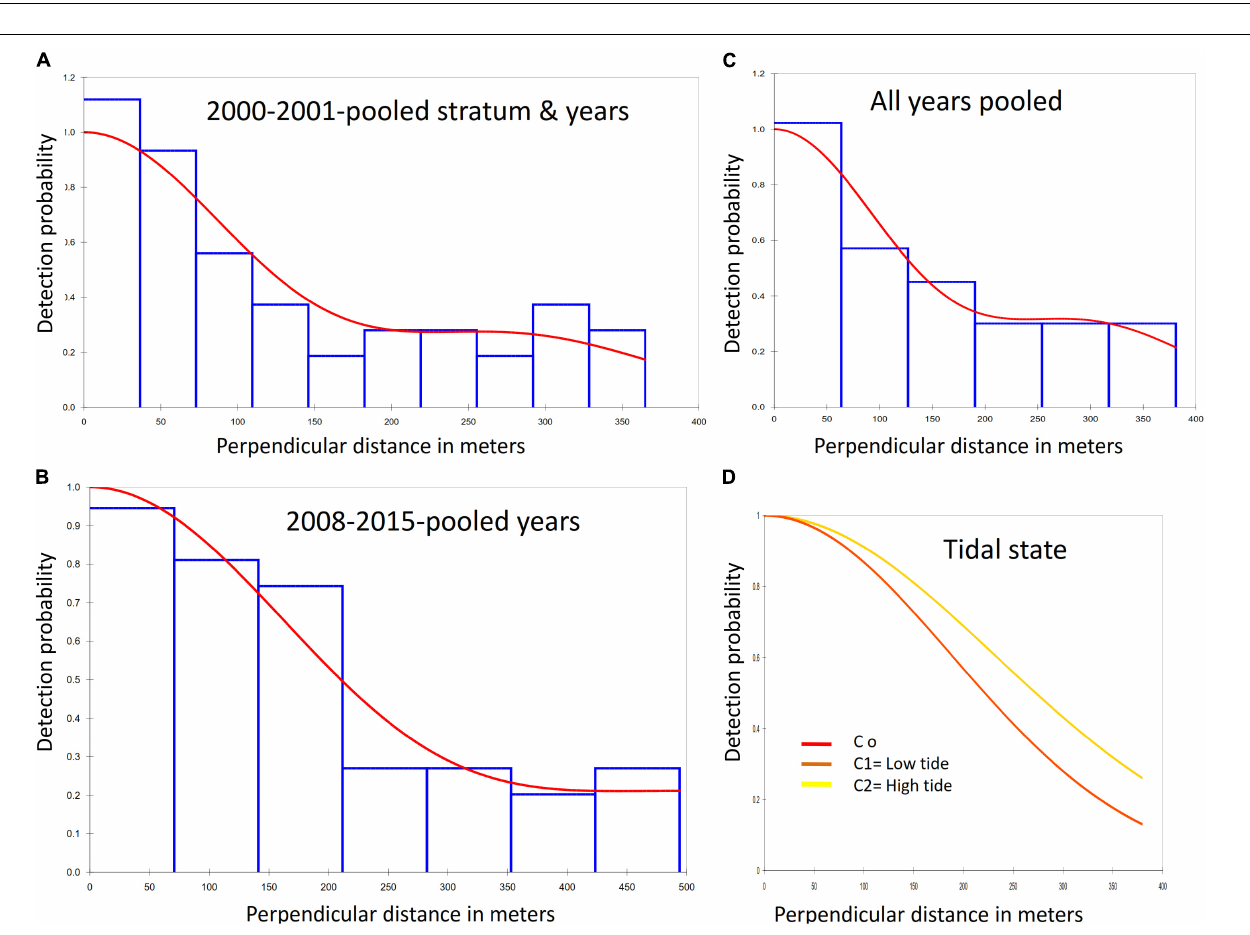
FIGURE 4 | Detection functions fitted to the perpendicular distances of observations of groups of Irrawaddy dolphins. (A) Best fitted detection function for years 2000–2001 with pooled survey stratum and years providing the probability of a greater chi-square value, P = 0.916. Data were grouped using 10 equal-spaced intervals and 10% truncation. The curve. (B) The detection function for years 2008 and 2015 with pooled survey years provided the probability of a greater chi-square value, P = 0.852. (C) Pooled years and stratum for 2000–2015. Data were grouped using 6 equal-spaced intervals and 10% truncation with the probability of a greater chi-square value, P = 0.807. (D) Detection function for covariates low and high tidal states.